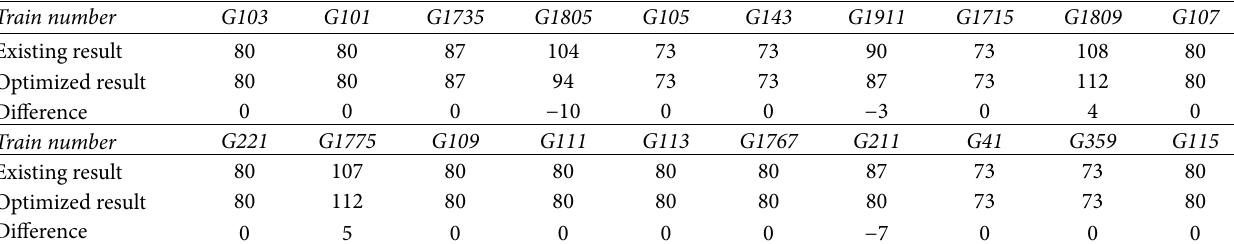
Table 5: Comparisons on the train travel time (unit:min).